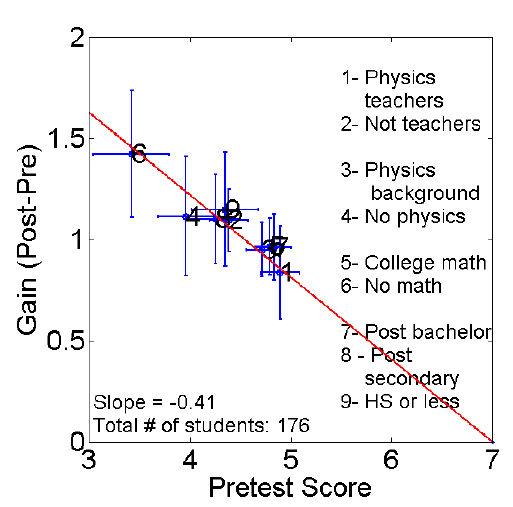
Figure 3 . The negative slope of the red line, constrained to go through the point (7,0), indicates the normalized gain that best fits the 176 students who answered five non- force-related and two symbolic items on both pre and posttests. The mean pretest and gain scores, with standard errors, are also shown for various